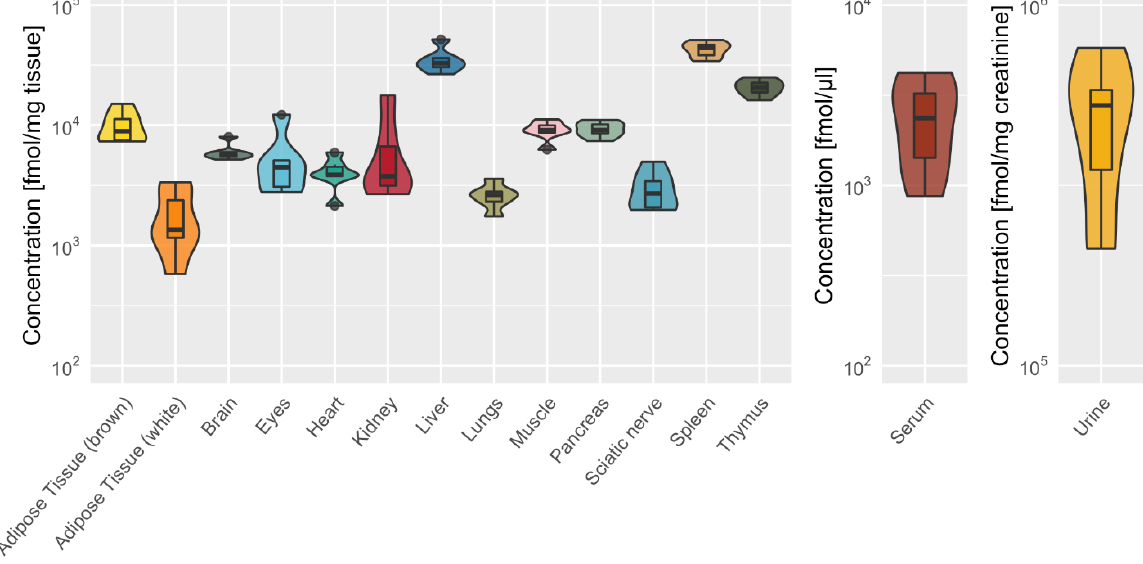
Figure 3. The sum of 28 dipeptides from various tissues and biofluids (as depicted in Figure 2). Sums are presented as violin blot showing median (bold line) with standard deviation ( n = 6; except for urine n = 5). Concentrations are given in fmol/mg tissue in tissue and in fmol/µL in tissue and in fmol/mg creatinine in urine.